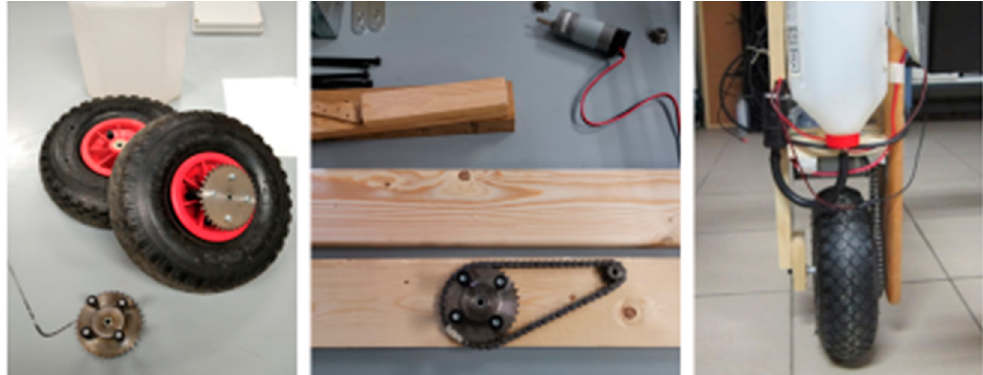
Figure 2. Various wooden and electromechanical components, used or new, such as tires, gears, chain drives, geared motors, windshield pumps, and reservoirs, used for constructing the robots.